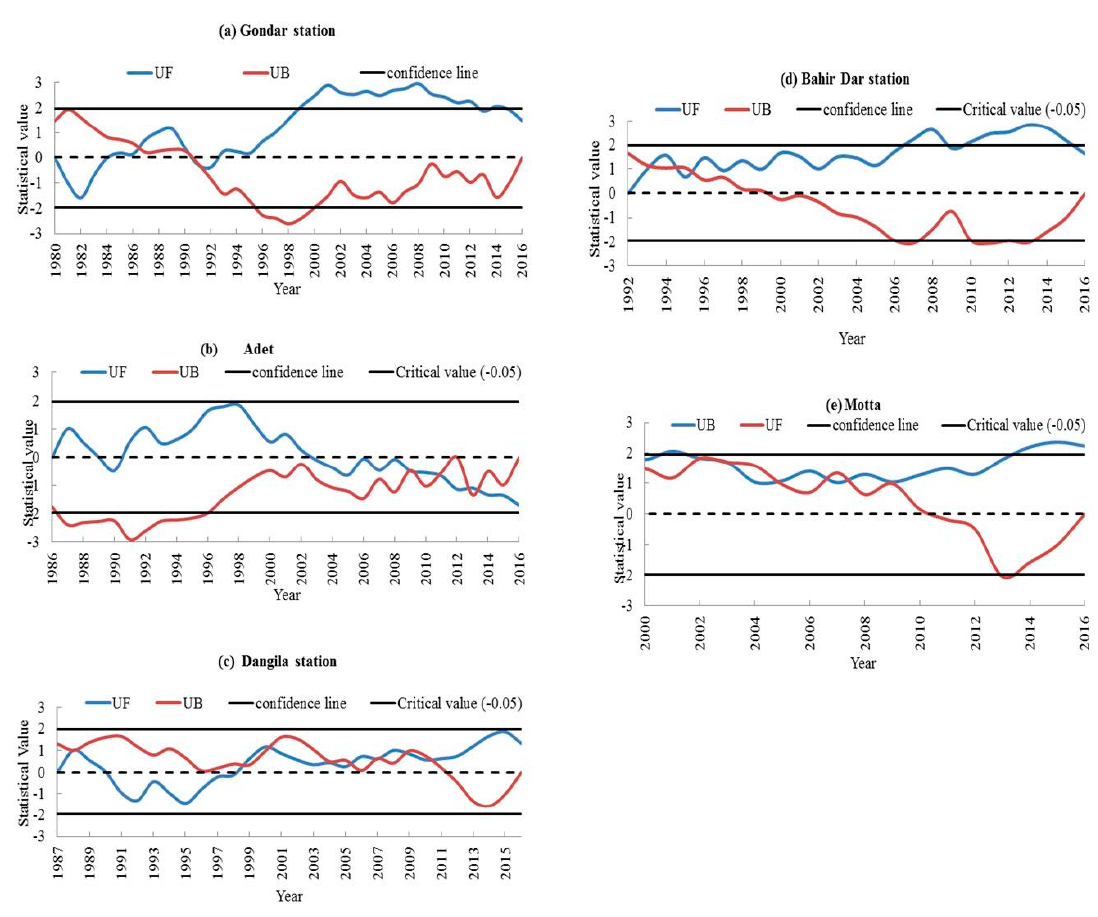
Figure 3. Trends of annual rainfall across stations (note: UB and UF are changing parameters where UB = − UF). Table 3. Results of Z-statistic of MK, ITAM ( ɸ ), and Sen’s slope estimator test ( β ). S/No.